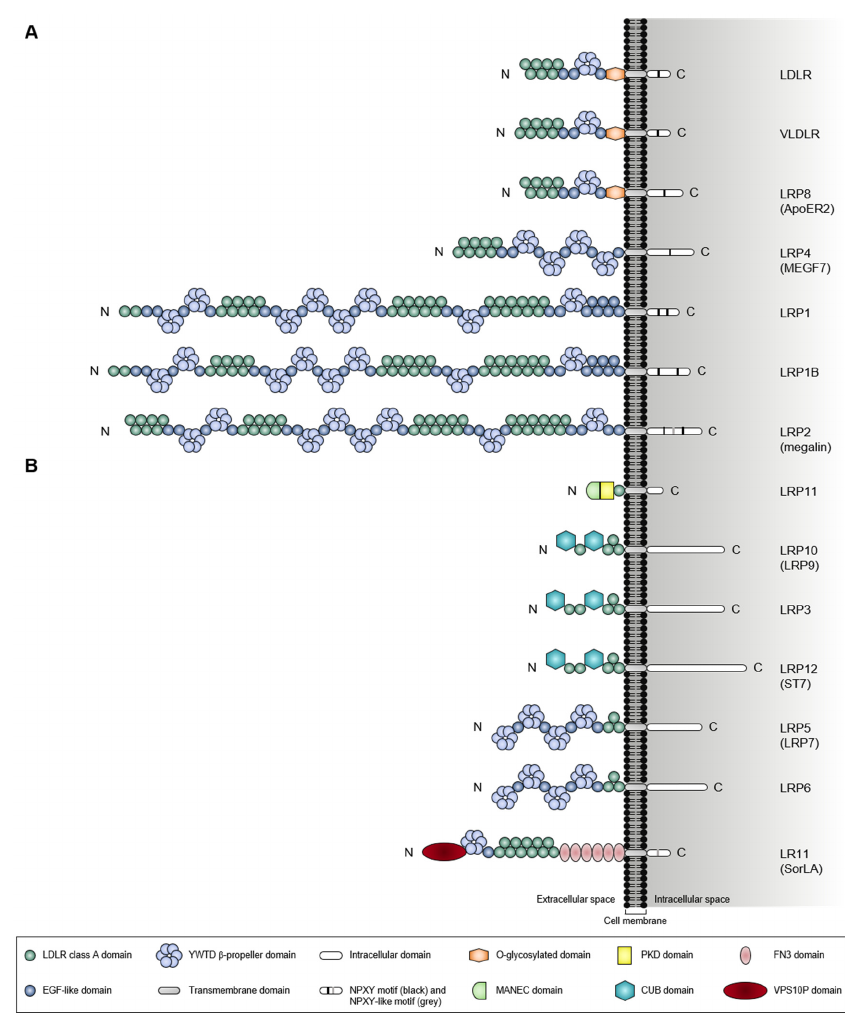
Figure 1. Human LDLR family members . Schematic representation depicting the domain organization of core ( A ) and distant-related ( B ) members of the human LDLR family. All members are anchored to the cell membrane by a single membrane-spanning domain and contain an intracellular domain ranging from 50 to 346 amino acids. These are type I membrane proteins (i.e., extracellular N-terminus and intracellular C-terminus; the presence of an N-terminus signal peptide). The core members ( A ) contain an extracellular domain built from a minimal central unit of an N-terminus cluster of LDLRA domains followed by a C-terminus cluster of EGF-like and YWTD β -propeller domains. LDLR, VLDLR, and LRP8 contain an additional extracellular O-glycosylated domain adjacent to the transmembrane domain. The core members also have an intracellular domain with at least one NPXY motif. The distant-related members ( B ) contain at least one of the extracellular domains of the core members. In addition, these also include domains that are not present in the core members. Abbreviations: LDLR, low-density lipoprotein receptor; VLDLR, very low-density lipoprotein re-ceptor; LRP, low-density lipoprotein receptor-related protein; EGF, epidermal growth fac-tor, YWTD, tyrosine-tryptophan-threonine-aspartate; NPXY, aspara-gine-proline-x-tyrosine (where x is any amino acid); MANEC, motif at the N-terminus with eight cysteines; PKD, polycystic kidney disease; CUB, complement C1r/C1s, Uegf, Bmp1; FN3, fibronectin type-III; VPS10P, vacuolar protein sorting ten